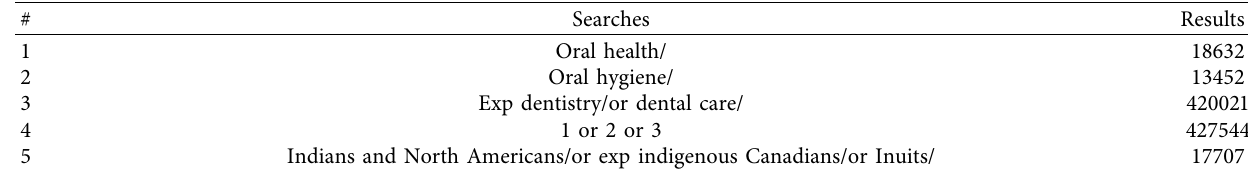
Table 1: The search strategy of the scoping